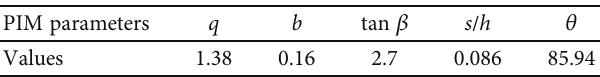
Table 5: RF-AGA-ENN model-derived PIM parameters of working face 11111.